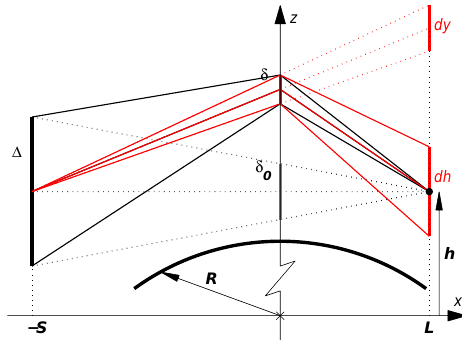
Figure 2. Simplified representation of the refraction plane geometry for the occultation of an extended light source at distance S of the Earth’s centre, observed by a satellite radiometer at distance L from the